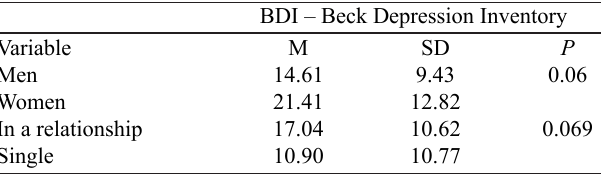
Table 2. Comparison of mean Beck Depression Inventory (BDI) scores between men and women and between single patients and patients in a relationship.